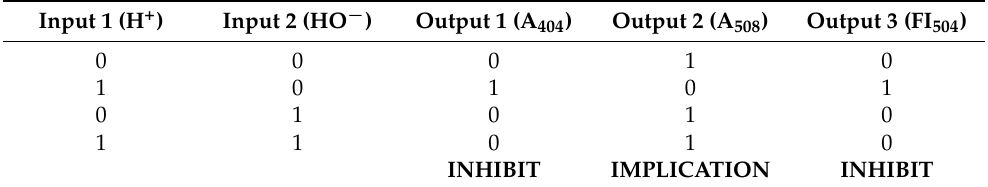
Table 2. Truth table for logic gates of 5 with two chemical inputs (H + and HO − ).